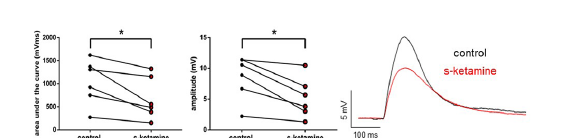
FIGURE6 s-ketamine significantly (*) decreased the AUC ( p = 0.031) and the amplitude ( p = 0.031) of intracortical NMDA-receptor mediated eEPSPs. Cohens’s U3_1 was each 0 (O O). Representative traces are shown on the